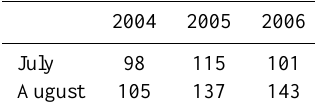
Table 1. Monthly mean net radiation (Wm − 2 ) at Agoufou (Mali, year) and 2006 (dry early monsoon, wet late monsoon). The shift